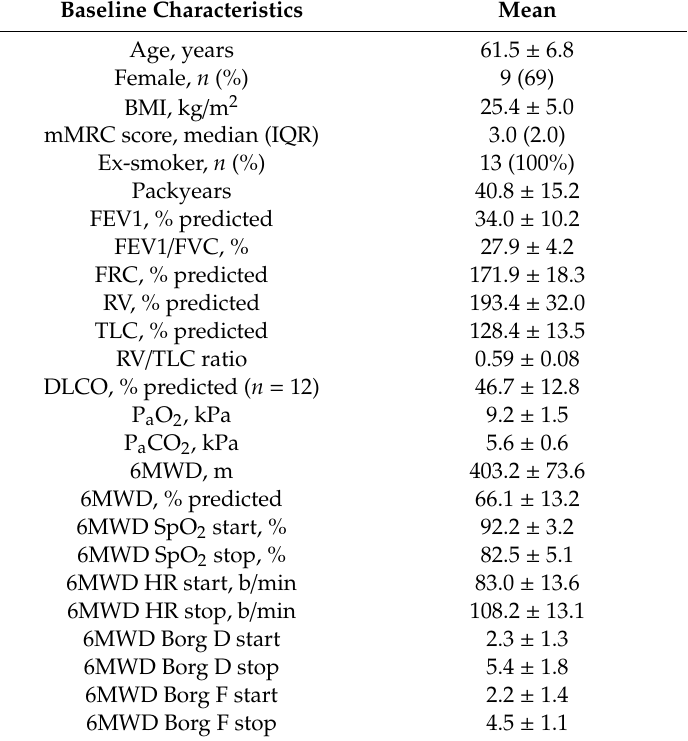
Table 1. Baseline characteristics n =